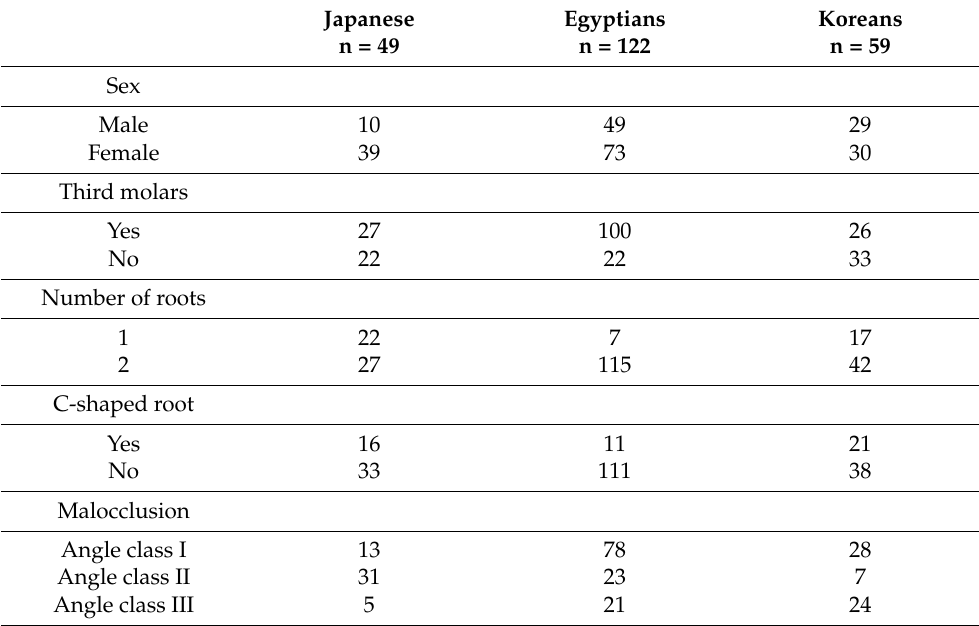
Table 1. Characteristics of the